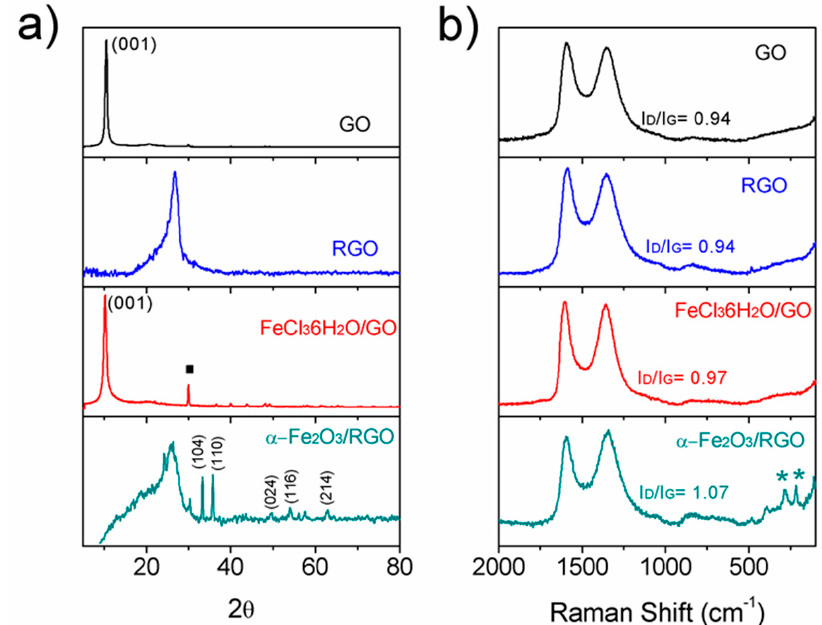
Figure 2. ( a ) X-ray diffraction (XRD) patterns of GO, reduced graphene oxide (RGO), FeCl 3 · 6H 2 O/GO, and α -Fe 2 O 3 /RGO hybrid material, planes and crystalline phases are marked; and ( b ) the Raman spectra of GO, RGO, FeCl 3 · 6H 2 O/GO, and α -Fe 2 O 3 /RGO hybrid material showing the microstructural characterization.